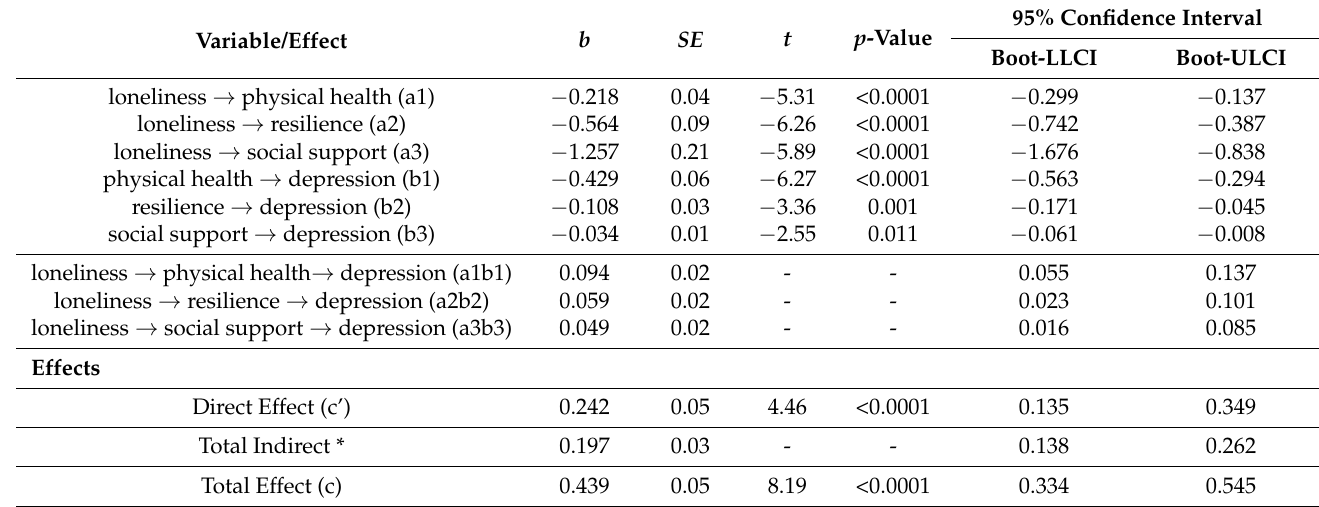
Table 3. Path coefficients for parallel mediation model.